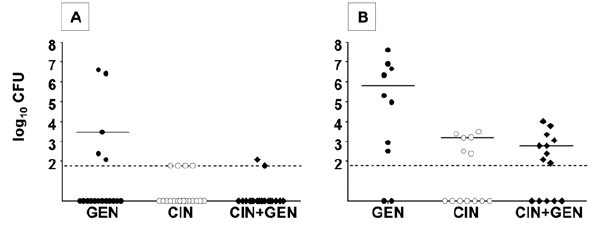
Figure 2. The effect of antibiotic treatment on bacterial load in the draining lymph node. Treatment with GEN at 25 mg/kg q24h (filled circles), CIN at 30 mg/kg q12h (open circles) and CIN at 30 mg/kg q12h in combination with GEN at 25 mg/kj q24h (filled diamonds) was initiated in mice 44 h (A) and 56 h (B) after the i.d challenge (100 CFU of Y. pestis ). Individual bacterial counts in the draining lymph node 5 days after the end of the course regimen are shown. Median values are indicated by bars. The dashed horizontal line represents the LOD ( # 1.8 log 10 CFU).